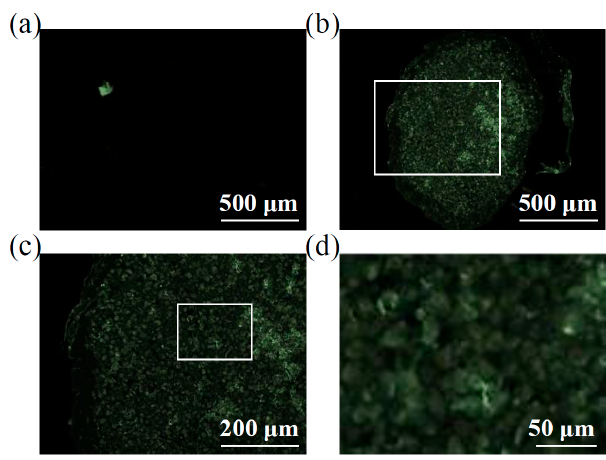
Figure 2. ASC-EVs endpoint incorporation in chondrocyte micromasses. ( a ) Transversal section of a representative chondrocyte micromass not treated with CFSE-EVs showing absence of background fluorescence. A representative picture is shown. ( b through d ) Increasing magnification of a representative chondrocyte micromass after incubation with CFSE-EVs, with the original region of panel c depicted in panel b by the white square as well as the original region of panel d being squared in panel c. It is possible to observe a homogenous signal all over the micromass section, including the center of the pellet ( b ) and, with a higher magnification ( c and d ), fluorescence results associated with both chondrocytes and intercellular matrix. Representative pictures are shown.